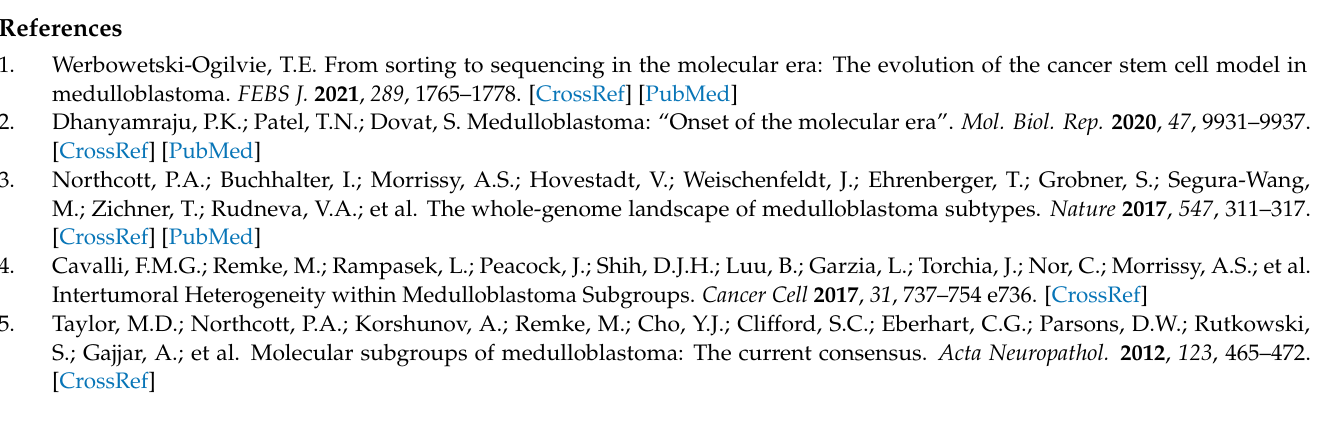
cell lines, Figure S3: Overall survival of patients for pluripotent transcription factors, Figure S4: DNA methylation profile of OCT4 locus in MB patients, Figure S5: OCT4 overexpression promotes TICs, tumorigenicity potential and drug resistance, Figure S6: RT2 profiler PCR profile shows the overlapping genes between tumorsphere(s) and OCT4 over-expressing MB cells, Figure S7: The ALK2/3 inhibitor, LDN 198836, decreases TICs and tumorigenic potential, Figure S8: The